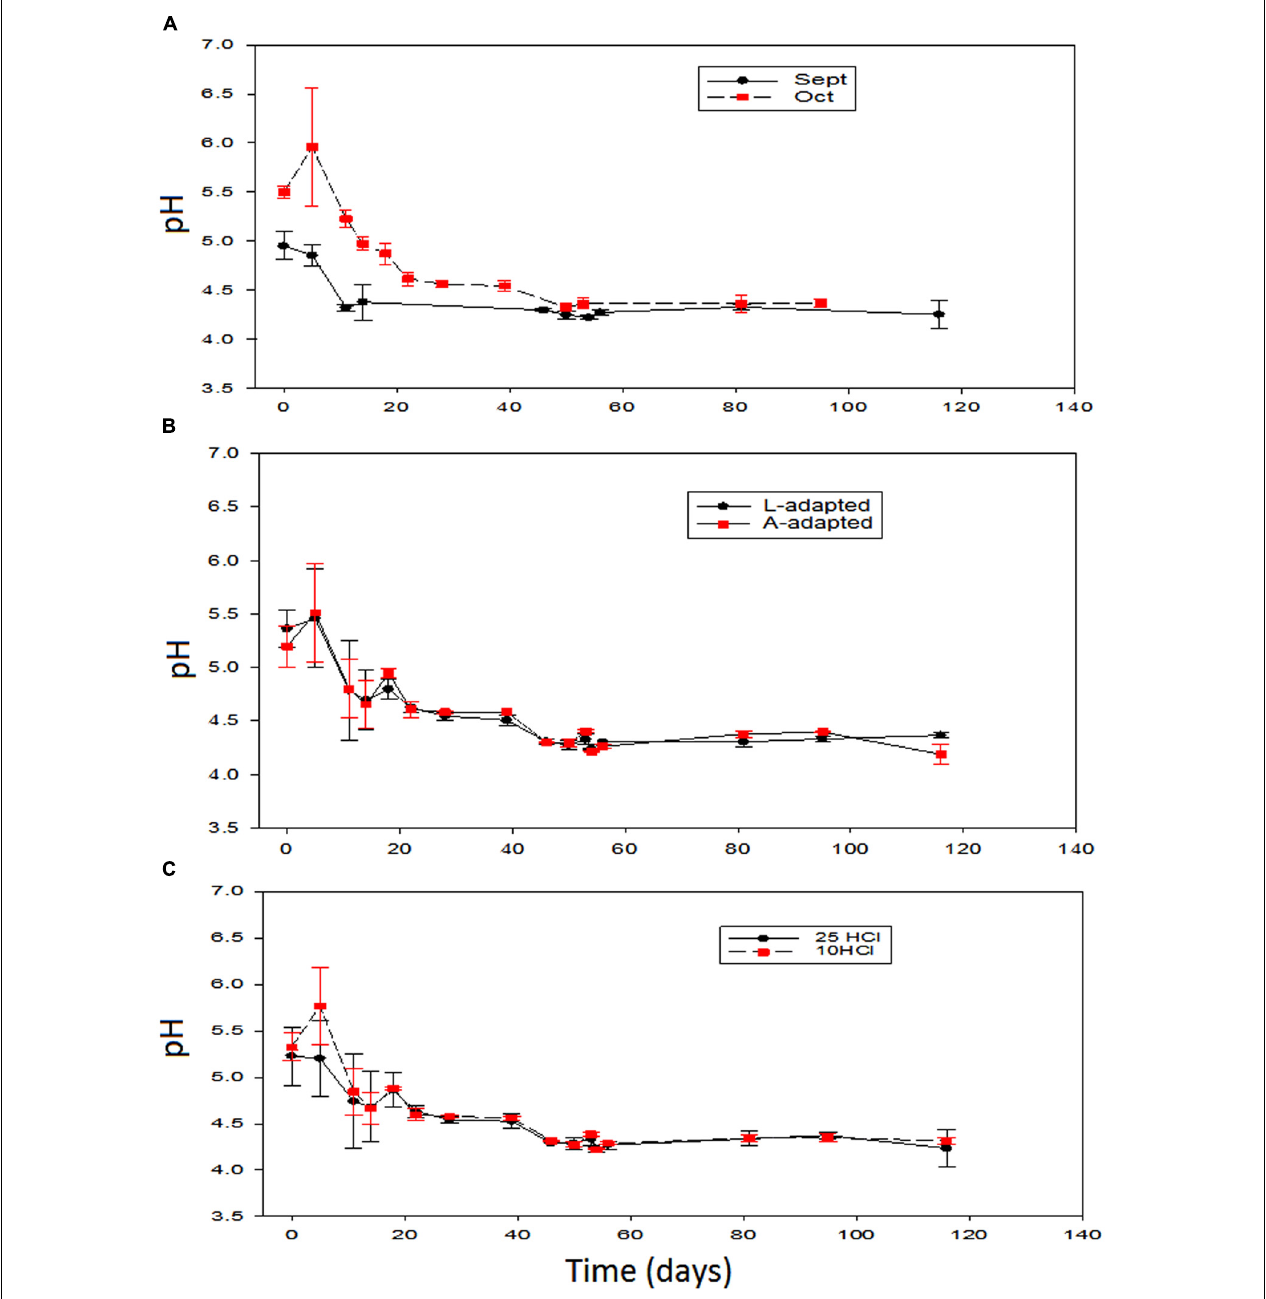
FIGURE 2 | Application of potential probiotic starter (LAB2) at industrial scale (season 2012/2013). Changes in pH ( ± CL, n = 4 for each level) according to time season (A) , type of inoculum (B) , and proportion of HCl added to fermentation vessels (C) . The values are always averages over the other two non-included in the graph variables. See Figure 1 for the the meanings of